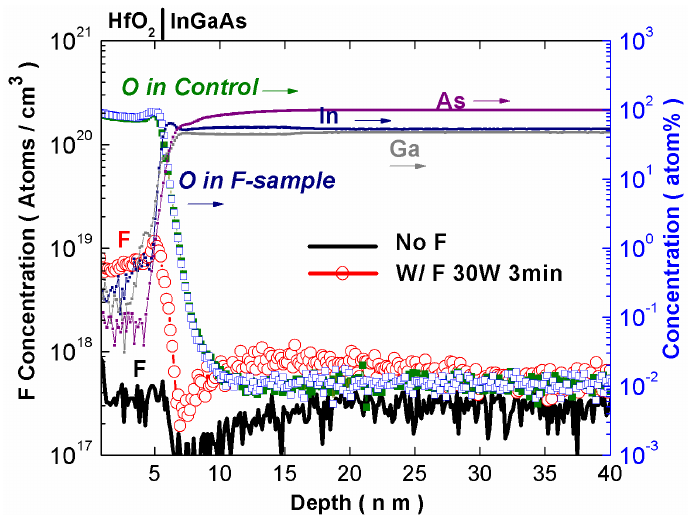
Figure 4. Secondary ion mass spectrometry (SIMS) profile of elements in the HfO /In Ga As gate stack with and without CF 2 0.53 0.47 plasma condition is 30 W for 3